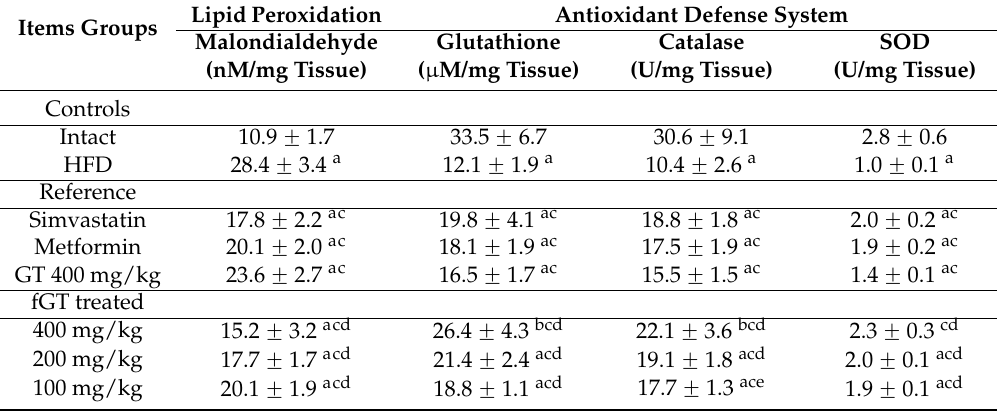
Table 9. Changes in the liver lipid peroxidation and antioxidant defense systems in NFD or HFD supplied